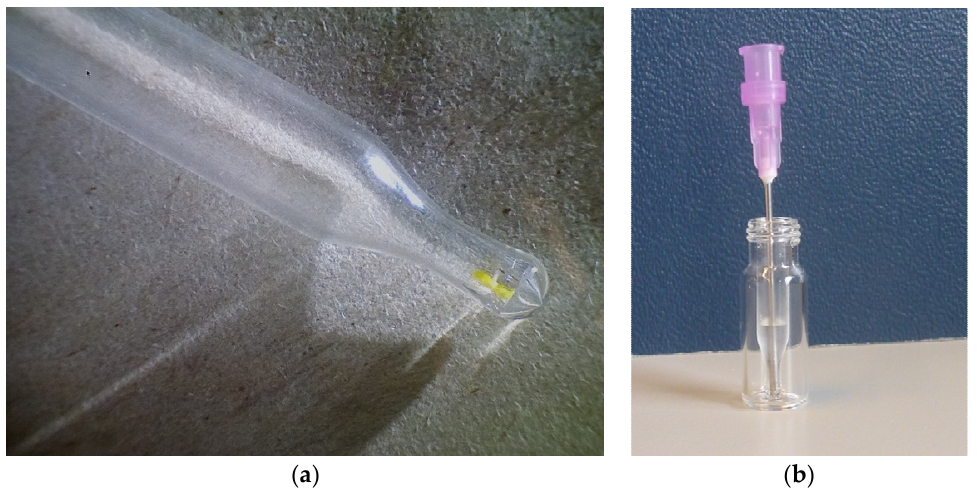
Figure 3. ( a ) bottom part of 250 μ L insert for 1.8 mL HPLC autosampler vial with < 0.1 mg weld-dyed wool sample at the very bottom; ( b ) autosampler vial with insert containing ∼ 100 μ L of extracted wool sample after filtration through a zero dead volume 5 μ m syringe filter. The purple needle filter can still be seen.